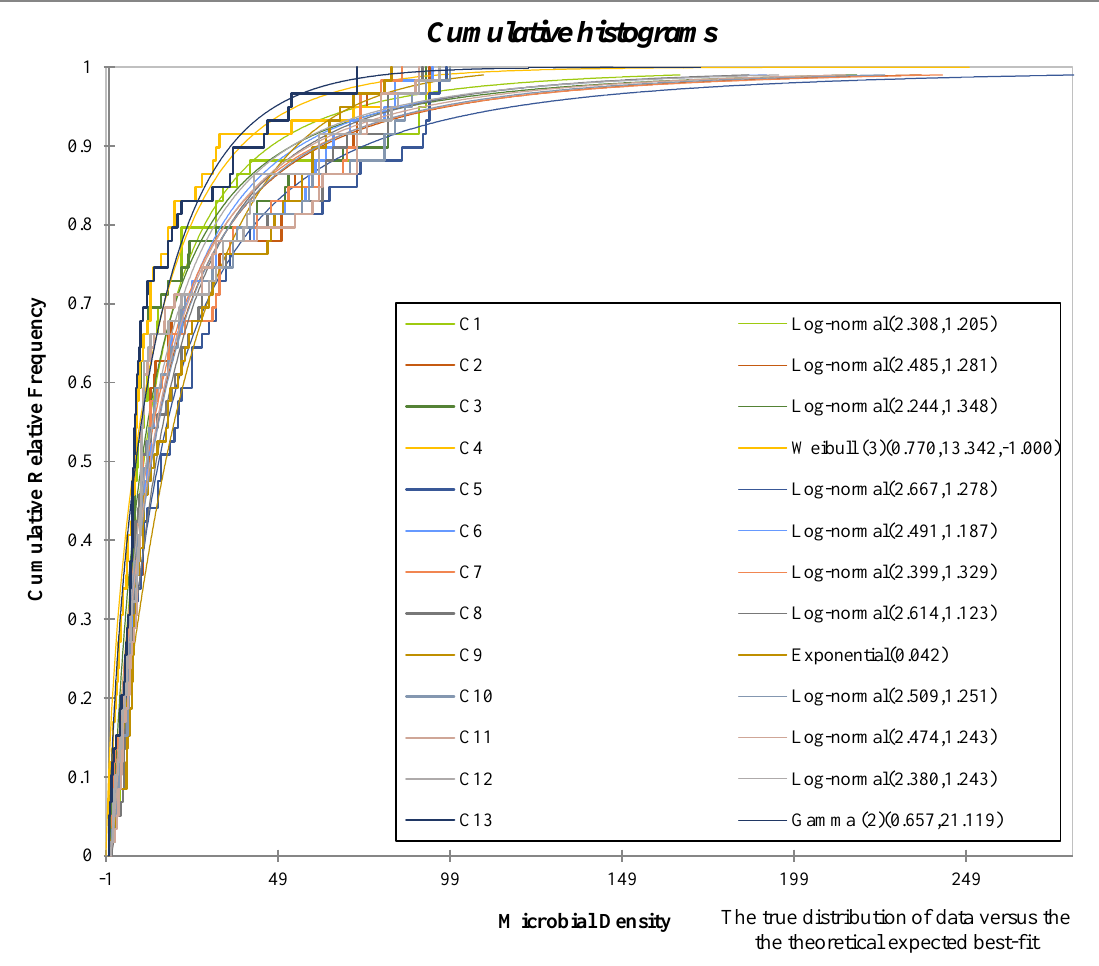
Figure 2. Cumulative histogram of the distribution points of municipal water network in the healthcare